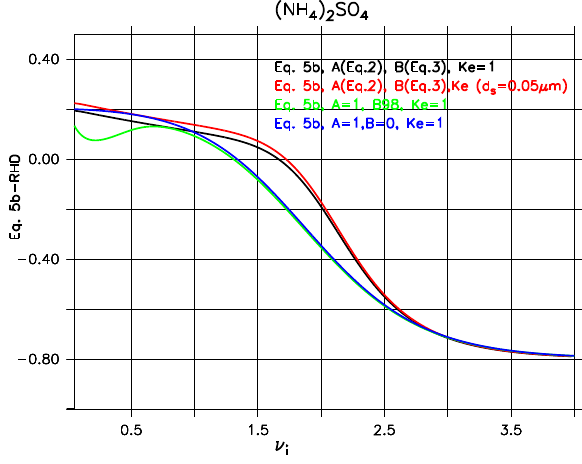
Fig. 9. ν i values for NaCl, satisfying “Eq. (5b)-RHD” using a root- finding algorithm.